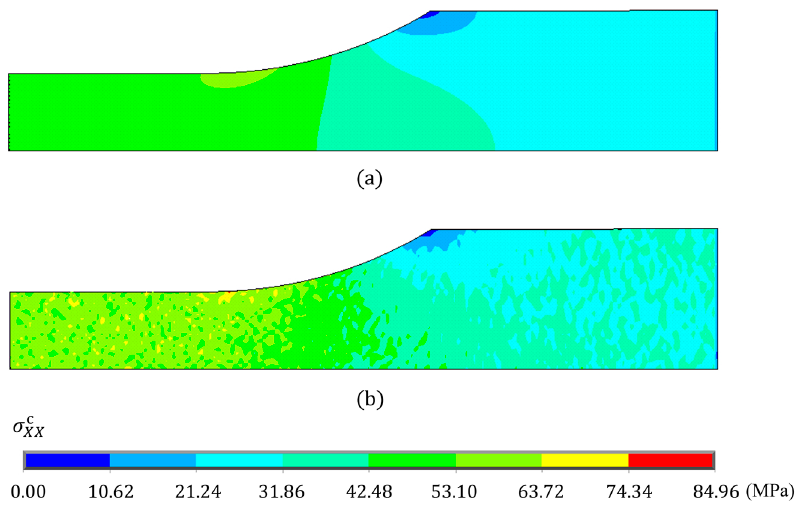
Figure 7. Predicted tensile stress σ c distributions of randomly oriented CNF / epoxy composite under the tensile strain of 0.015 obtained from ( a ) linear FEA and ( b ) multi-scale FEA. The volume fraction is 2.2 vol %, and the aspect ratio is 7.5.